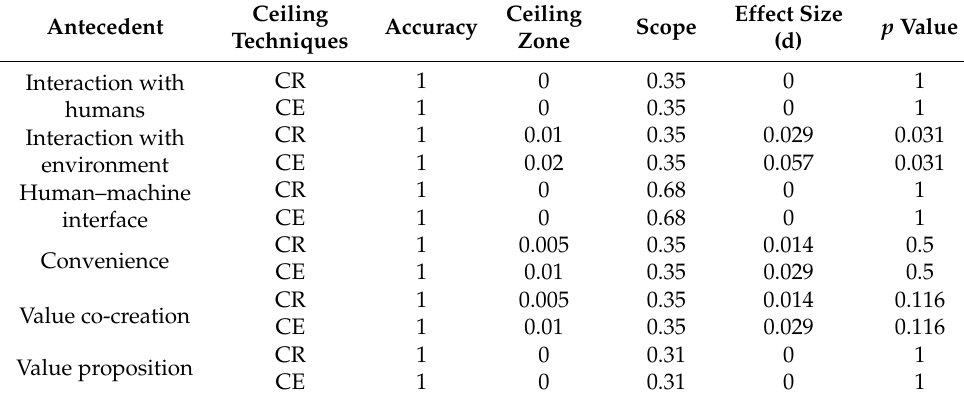
Table 6. NCA results.